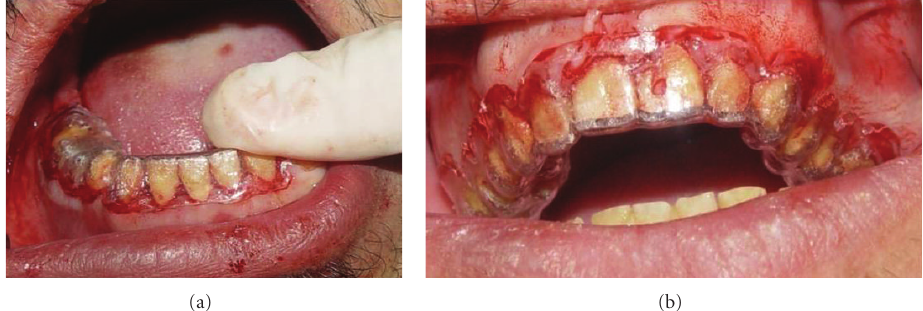
Figure 6: Crown lengthening according to fabricated stent: (a) in mandible; (b) in maxilla.